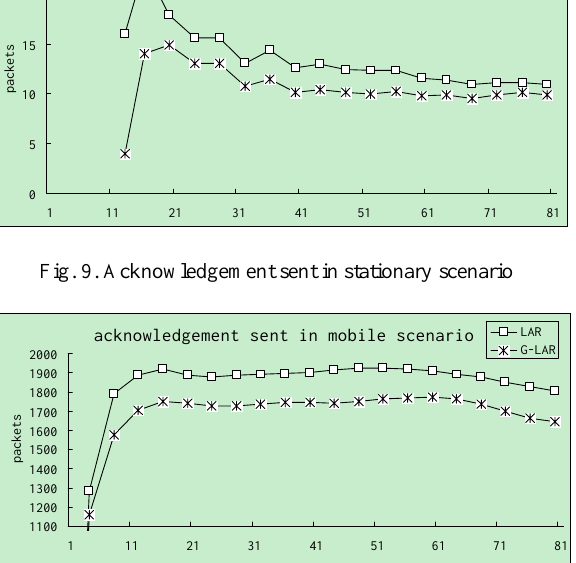
Fig. 10. Acknowledgement sent in mobile